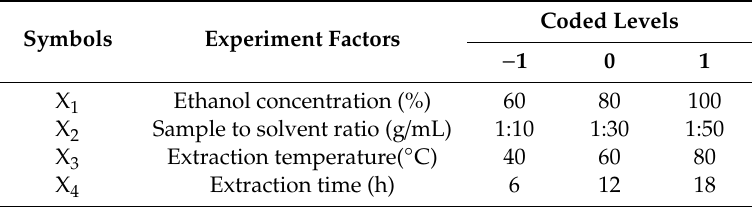
Table 1. Coded settings for the process parameters for extraction according to a Central composition design design of